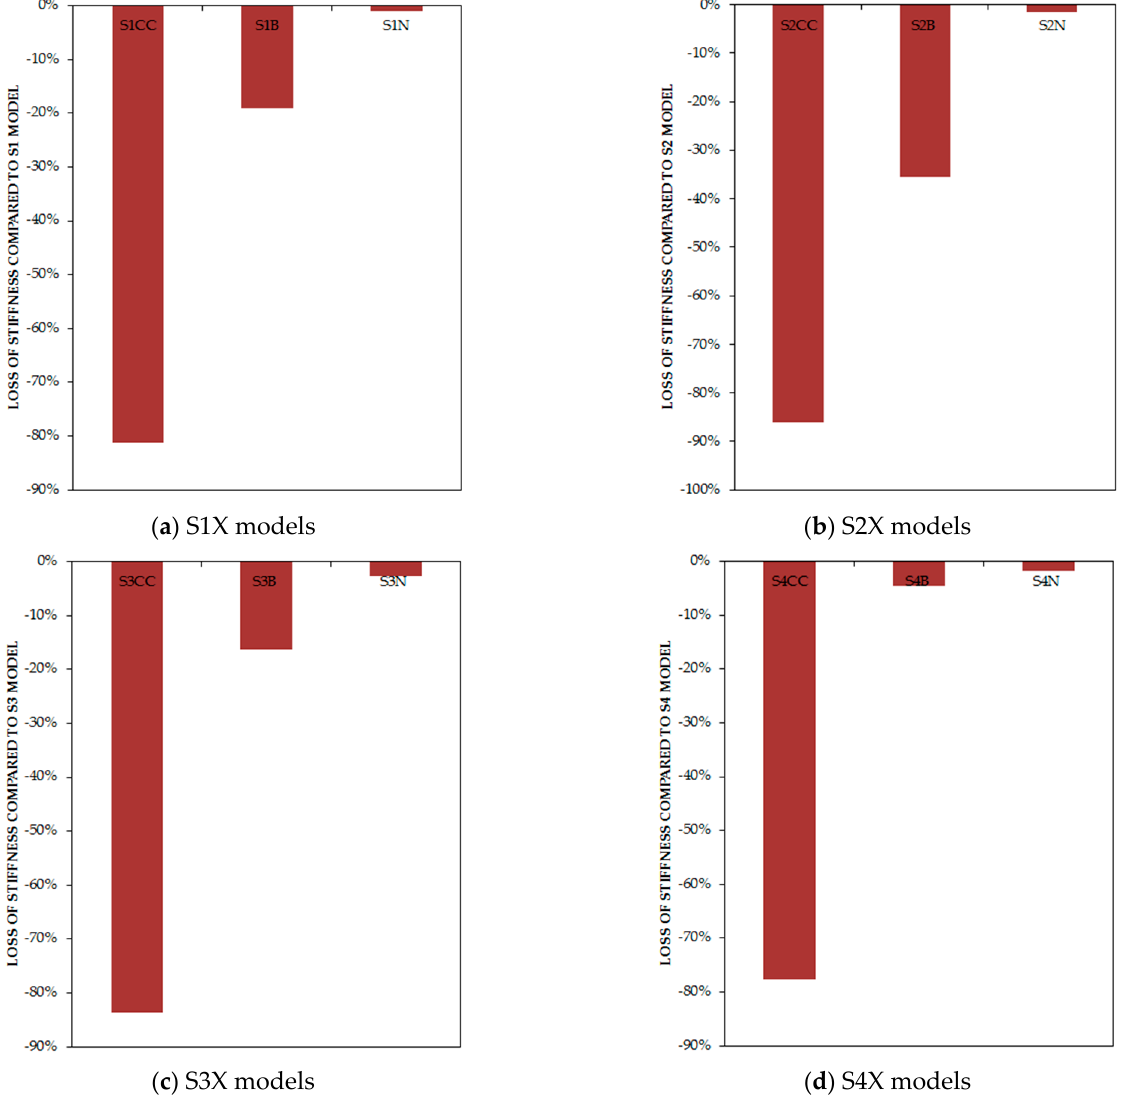
Figure 11. Loss of stiffness of models based on the type of connections in comparison with full- connection models by percentage.